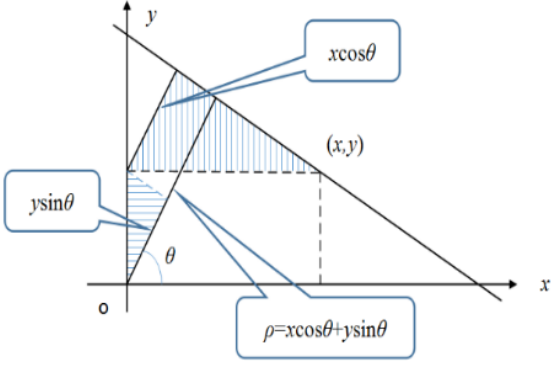
Figure 9. In the figure, 𝜃 is the angle between the line perpendicular to the line and the X -axis. 𝜌 is the distance between the origin and the given line.